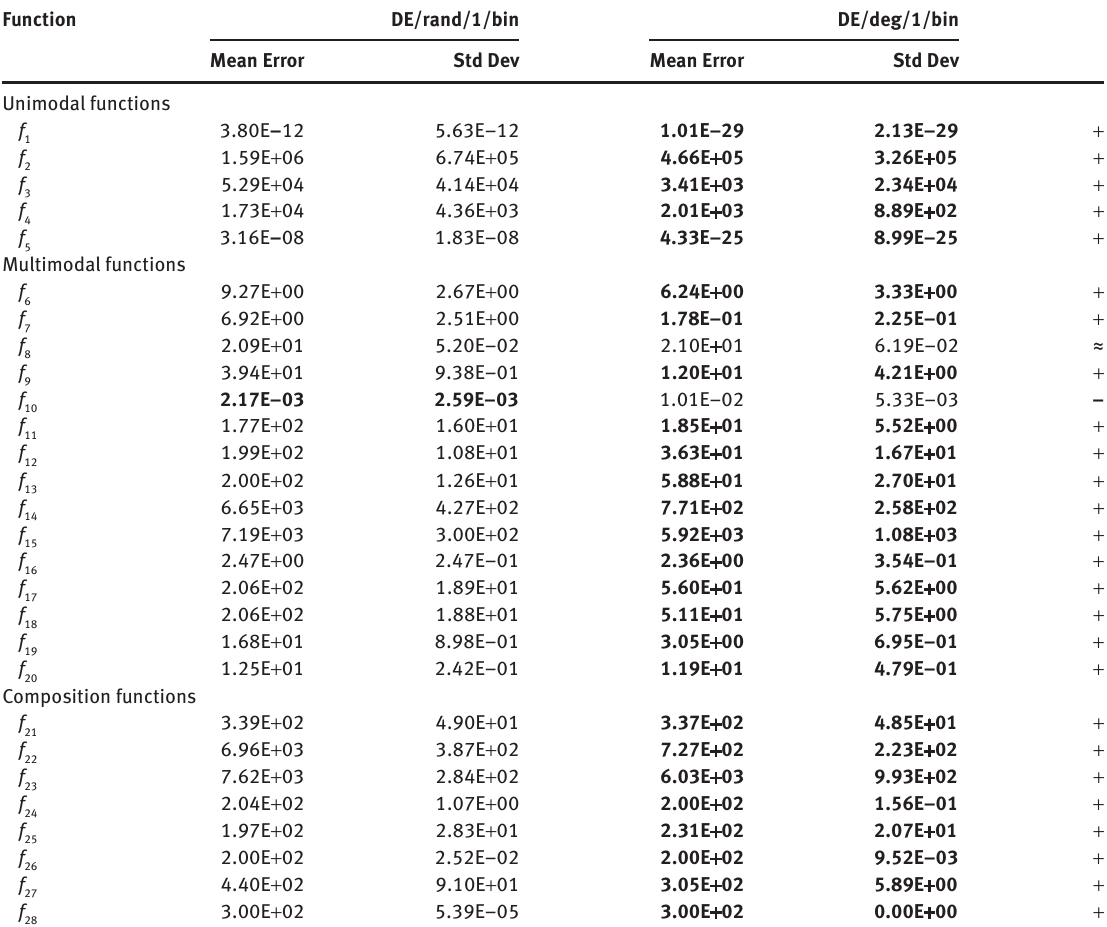
Table 1: Experimental Results of DE/rand/1/bin and DE/deg/1/bin over 50 Independent Runs on 28 Test Functions of 30 Variables with 300,000 Function